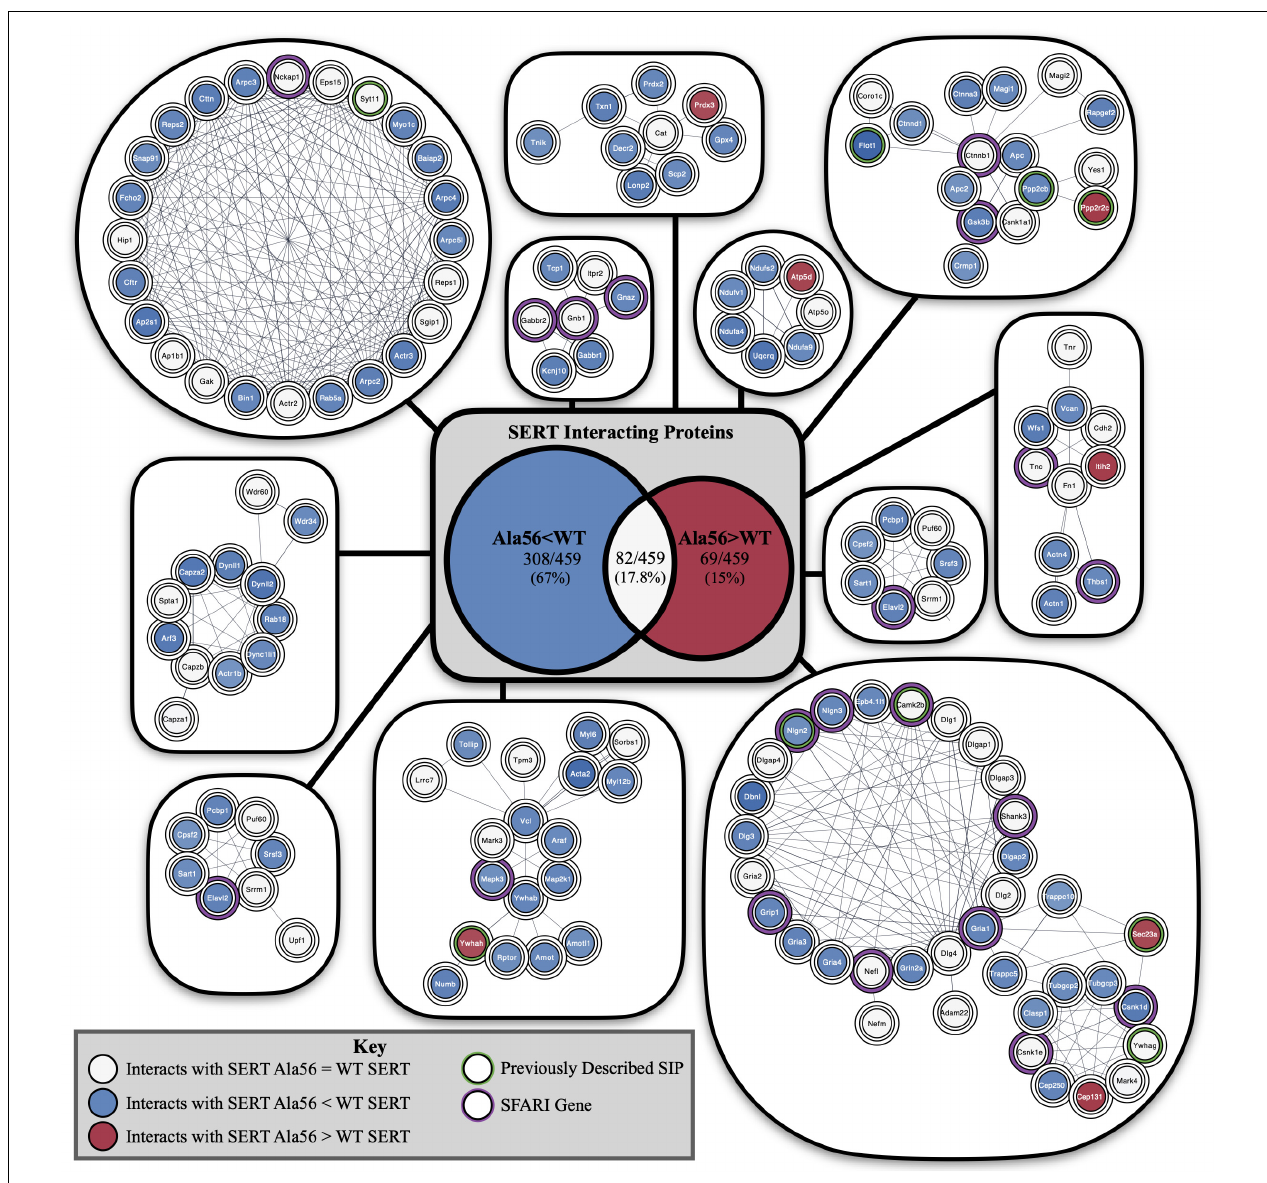
FIGURE 3 | STRING network analysis of all interacting proteins. Network of protein–protein interactions from the Cytoscape Omics Visualizer plug-in with STRING (confidence score cut-off of 0.9) followed by application of the MCL algorithm using clusterMaker2 app, with a minimum size of 7 proteins per cluster. Highlighted proteins previously identified to interact with SERT with a green outline and identified SFARI genes with a purple outline. Center shows Venn diagram of proteins with decreased interactions with SERT Ala56 compared to WT SERT (blue), number of proteins with increased interactions with SERT Ala56 compared to WT SERT (red) and number of proteins with similar interaction with both SERT Ala56 and WT SERT (light